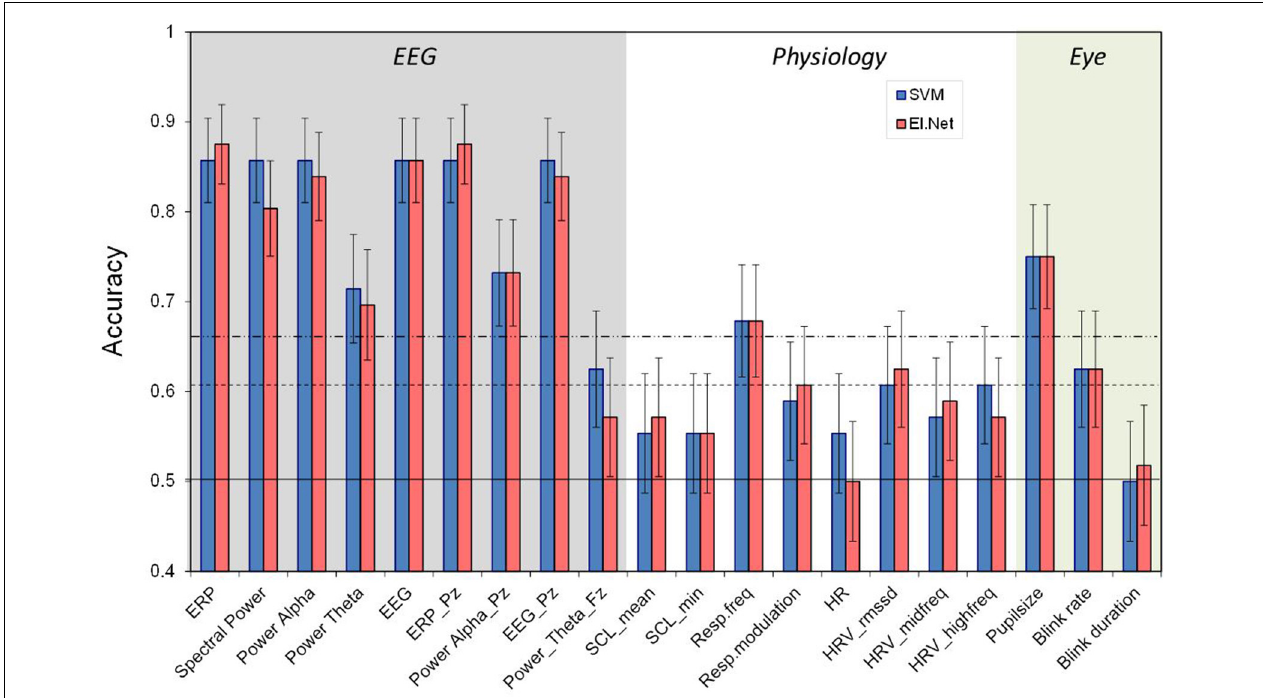
FIGURE 1 | Classification performance (2- vs. 0-back, 120s) for separate features as resulting from SVM and elastic net classification models. The horizontal lines indicate chance level ( bottom ), 0.05 significance level